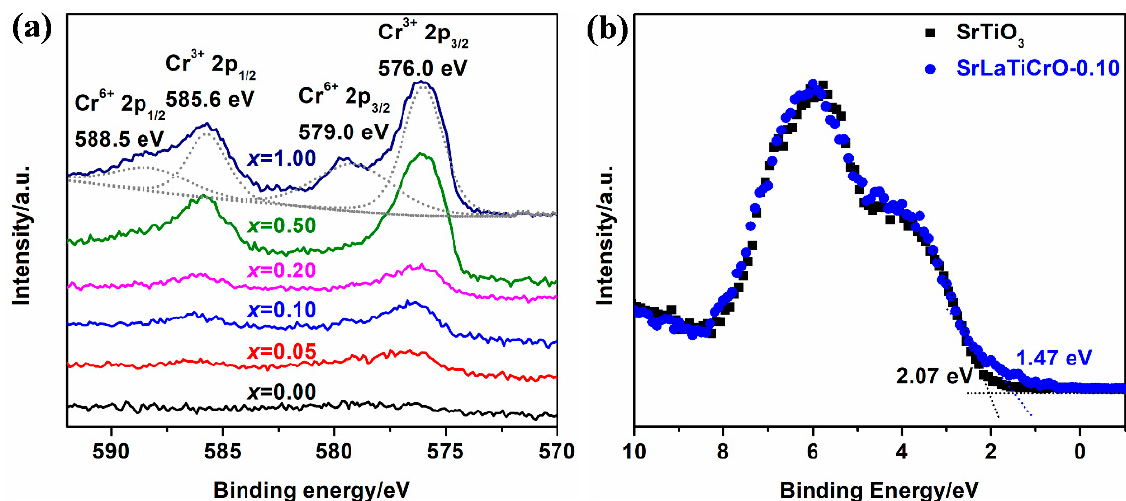
Figure 3. ( a ) High-resolution XPS spectra of Cr 2p orbitals of the SrLaTiCrO-x samples with x equal to 0.00, 0.05, 0.10, 0.20, 0.50 and 1.00. ( b ) VB spectra of SrTiO 3 and SrLaTiCrO-0.10. The XPS valence band (VB) spectra of SrTiO 3 and SrLaTiCrO-0.10 are shown in Figure 3b. The intercept of the tangent line on the valence band spectrum in the low binding energy region could reflect the relative energy level of the valence band mini- mum (VBM). As obtained from the VB curve, the VBM of SrLaTiCrO-0.10 shifted